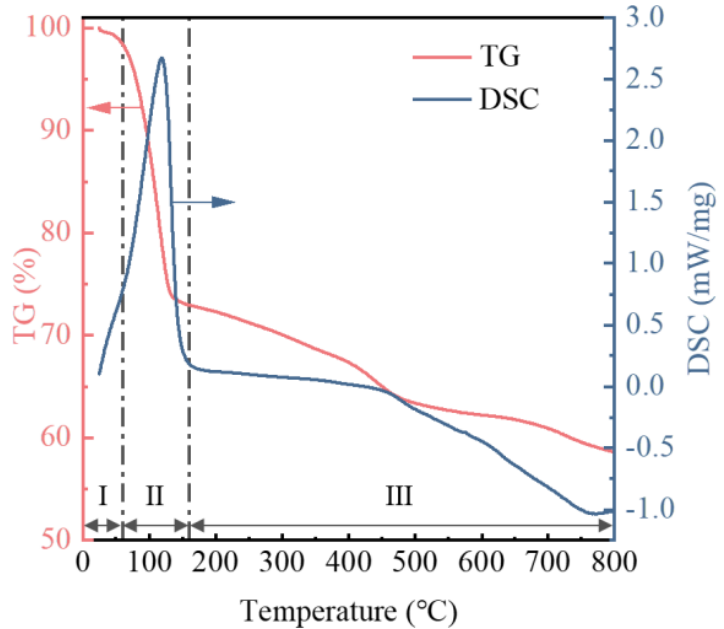
Figure 9. Thermogravimetric curves of oily sludge.